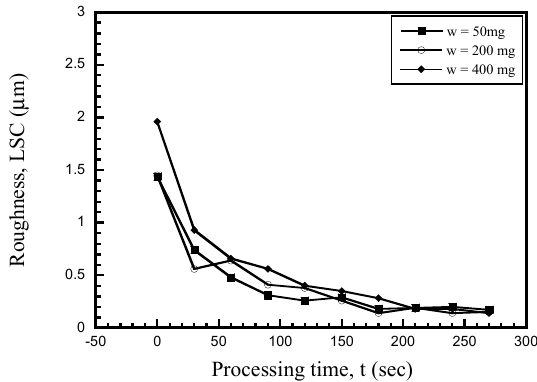
Figure 13. Variations of roundness against processing time. (diamond paste size: 1 µm, frequency of magnetic poles: 12 Hz).